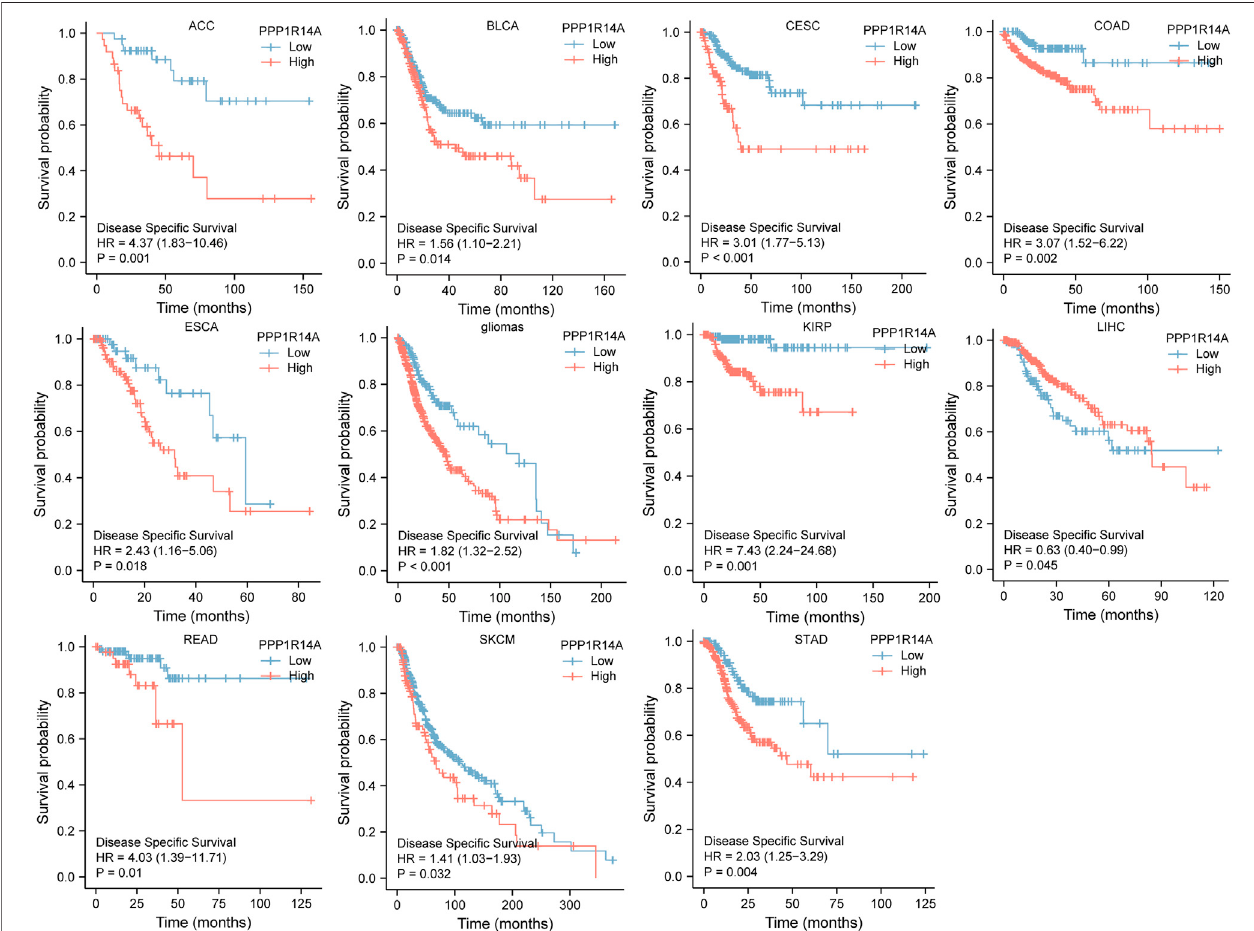
FIGURE 5 | Association between the PPP1R14A expression and the DSS of cancer patients. Kaplan – Meier survival curves for patients strati fi ed by the different expressions of PPP1R14A in ACC, BLCA, CESC, COAD, ESCA, gliomas, KIRP, LIHC, READ, SKCM, and STAD.